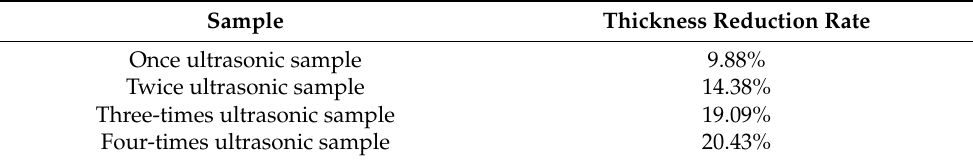
Figure 9. ( a ) Tensile strength of samples with different ultrasonic strengthening times. ( b ) Bending strength of samples with different ultrasonic strengthening times. Table 6. Sample thickness reduction rate statistics.